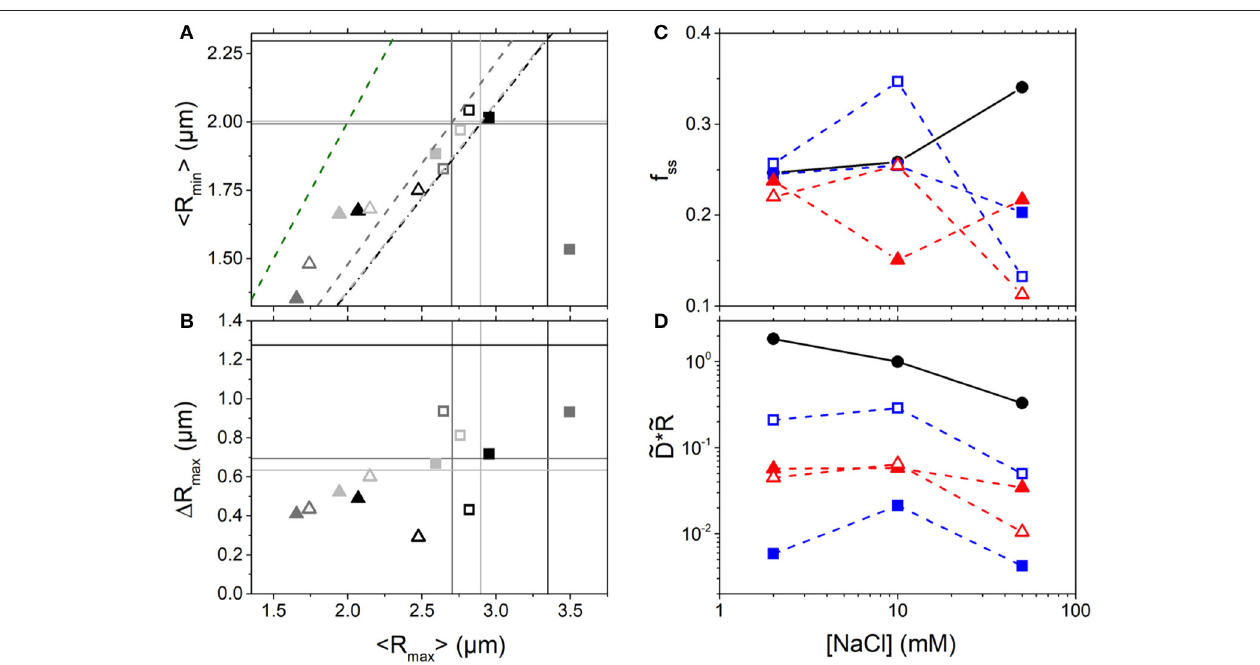
FIGURE 4 | Conformation and mobility of crowded DNA display unexpected non-monotonic dependence on NaCl concentration. (A) Phase plot of the mean major and minor axis lengths ( < R max > , < R min > ) for DNA crowded by 10 kDa (open symbols) and ∼ 500 kDa (closed symbols) linear (squares) and branched (triangles) crowders at NaCl concentrations of: 2mM (light gray), 10mM (gray), and 50mM (black). The intersections of the color-coded horizontal and vertical lines denote the buffer condition values at the corresponding salt concentration. The dashed lines show the color-coded < R max > : < R min > ratio (i.e. degree of sphericity) for the corresponding DNA conformations in buffer conditions. The green dashed line denotes the < R max > : < R min > ratio for a spherical particle. (B) Phase plot of the mean major axis length < R max > and corresponding standard deviation 1 R max . Colors and symbols are as in (A) . As shown, 10mM salt conditions lead to the most pronounced crowding-induced compaction and elongation (smallest and largest R max ) compared to lower and higher salt conditions. (C) Steady-state conformational fluctuation range of DNA, f ss , as a function of [NaCl] for solutions with no crowders (black circles) and 40% w/v 500 kDa dextran (closed blue squares), 10 kDa dextran (open blue squares), 420 kDa Ficoll (closed red triangles), and 10 kDa PEG (open red triangles). (D) DNA diffusion coefficients D , scaled by the corresponding empirical DNA size R , vs. [NaCl]. D and R are both normalized by the corresponding value in buffer with 10mM NaCl, denoted by tilde ( ˜ D , ˜ R ). Color scheme is as in (C)